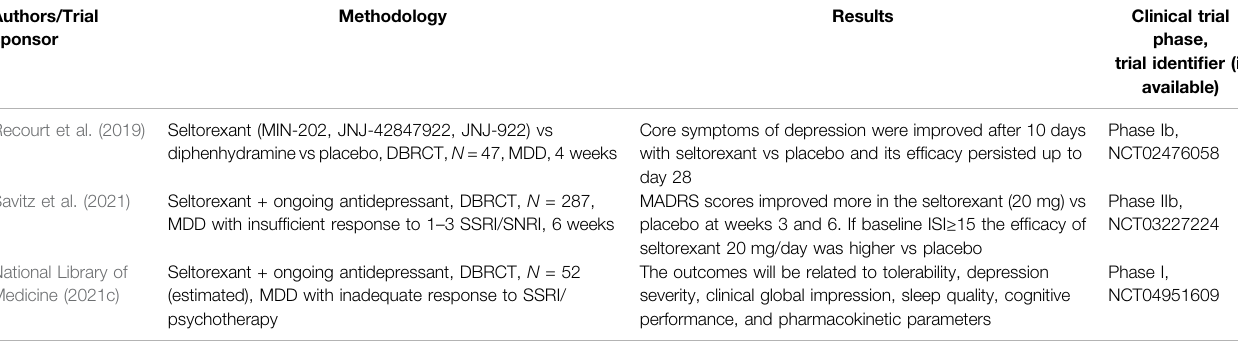
TABLE 4 | Orexinergic agents with antidepressant properties in the